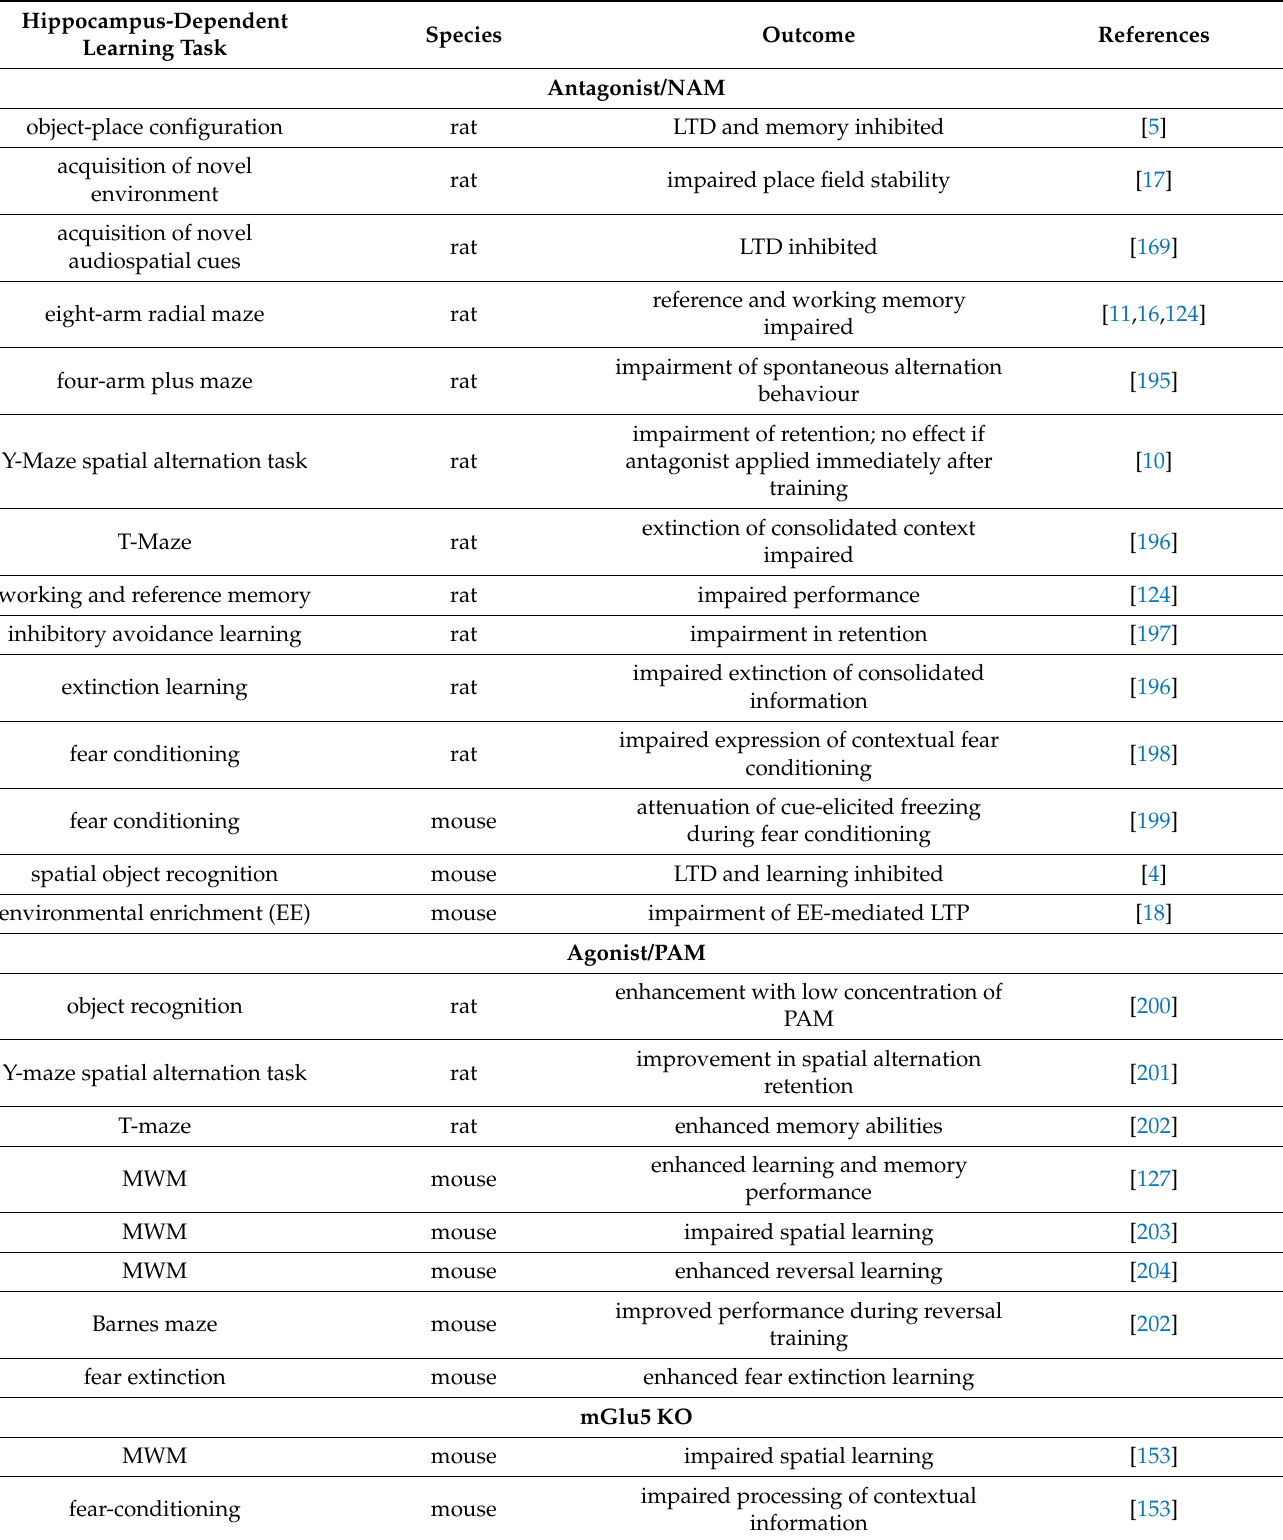
Table 2. Summary of mGlu5 receptor contribution to hippocampal to hippocampus-dependent learningKO: knock-out; MWM: Morris water maze; NAM: negative allosteric modulators; PAM: positive allosteric